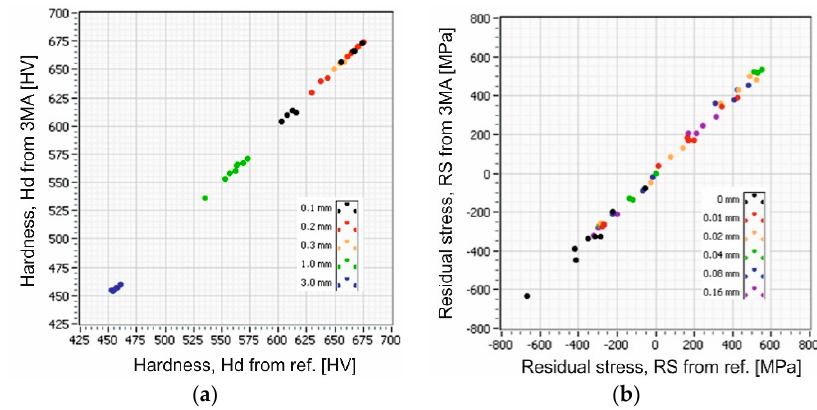
Figure 25. Results of the calibration to depth ‐ dependent material properties: ( a ) hardness at depths of 0.1, 0.2, 0.3, 1.0, and 3.0 mm and ( b ) residual stress at depths of 0, 0.01, 0.02, 0.04, and 0.06 mm.